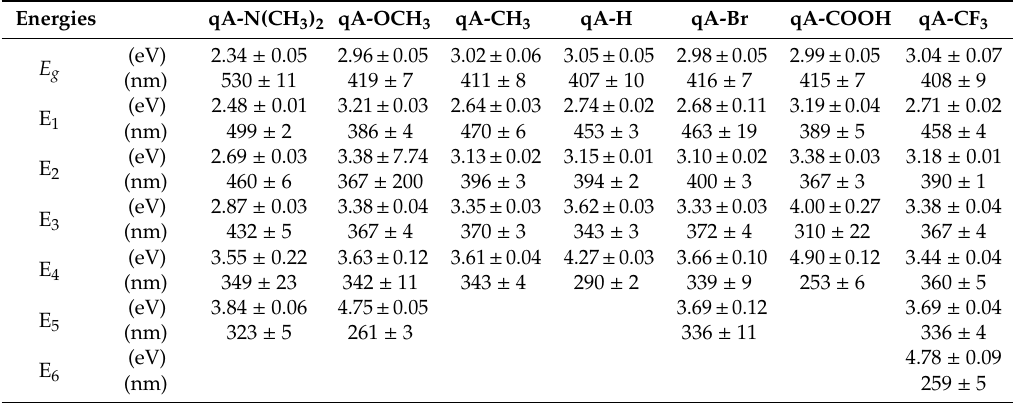
Table 3. The values of energy band gap ( E g ) and energies of interband transitions for quinoline azo-dye polymers with various electron donating and electron withdrawing substituents.